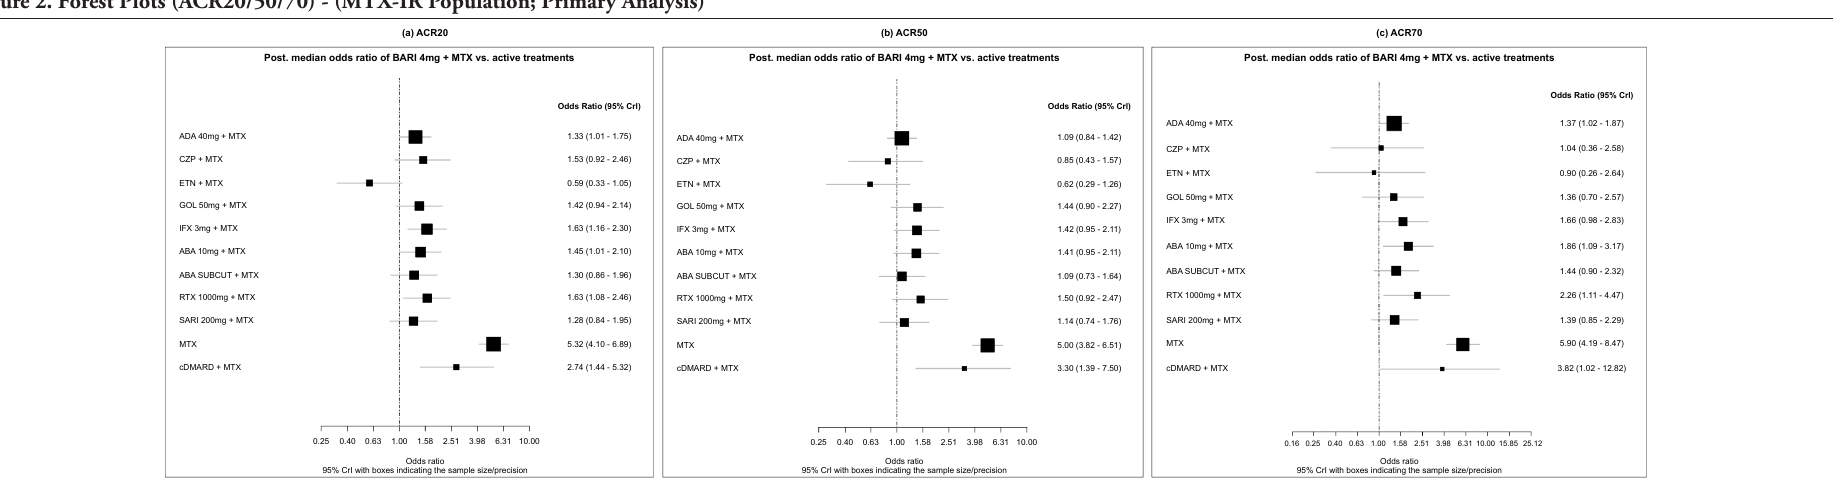
Odds ratios (OR) presented refer to BARI 4 mg + MTX vs active treatments. Therefore, ORs >1 are in favor of BARI 4 mg + MTX, whereas ORs <1 are in favor of the comparator. The primary analysis includes 19 trials for ACR20 and 18 trials for ACR50/ACR70. Figure 3. Forest Plots (ACR20/50/70) (MTX-IR Population; Sensitivity Analysis [1])